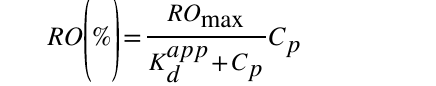
Figure 2. Schematic illustration of a model for description of E2110 PK/PD. C compartment; C , E2110 concentration in the effect compartment; k e central volume of distribution; V , peripheral volume of 2